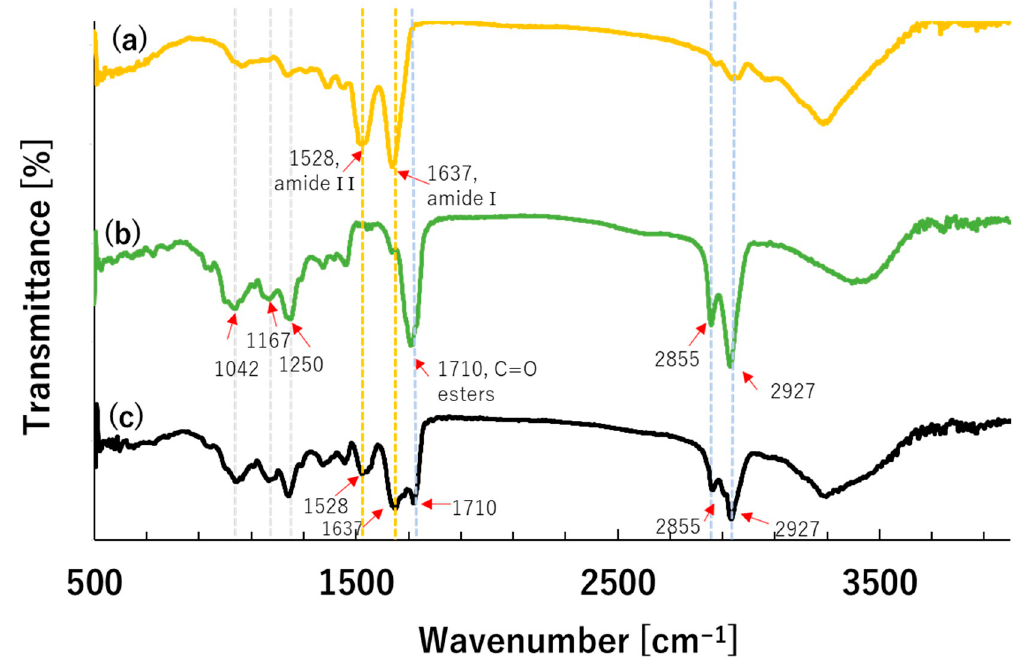
Figure 5. FTIR spectra of ( a ) crude Lf; ( b ) shellac and ( c ) Lf encapsulated shellac microcapsules produced by PGSS process of scCO 2 solutions at 40 °C and 10 MPa.